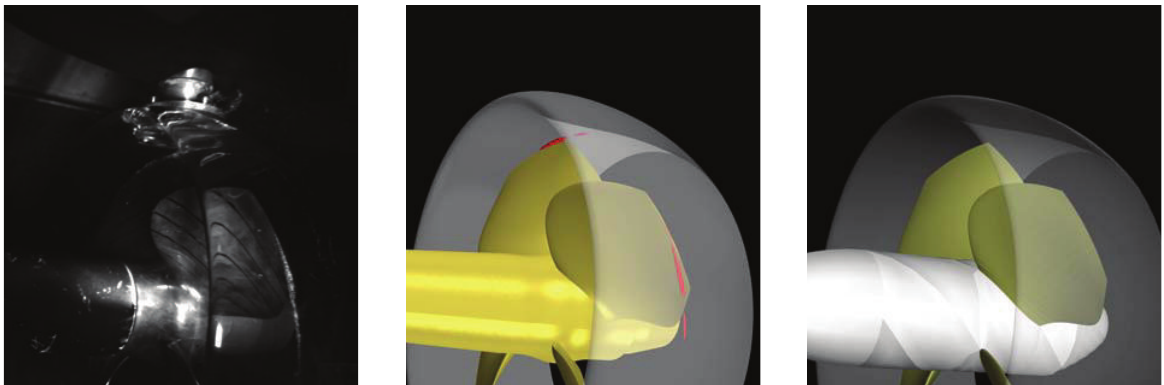
Figure 17: Observed and predicted (RANS and panel method) cavity extension. 70% of the design thrust coe ffi cient at the design cavitation